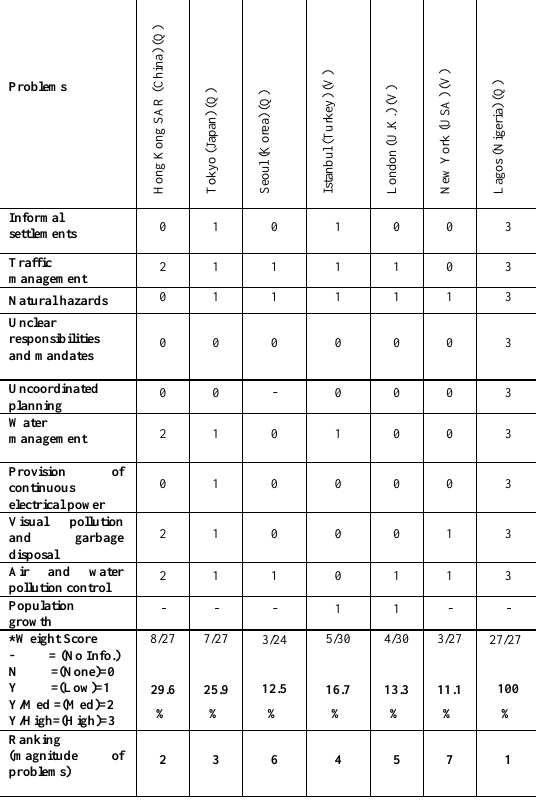
Table 2. City Administration Problems in Selected Megacities (Source: Adapted from the Research Study by FIG Commission 2010)